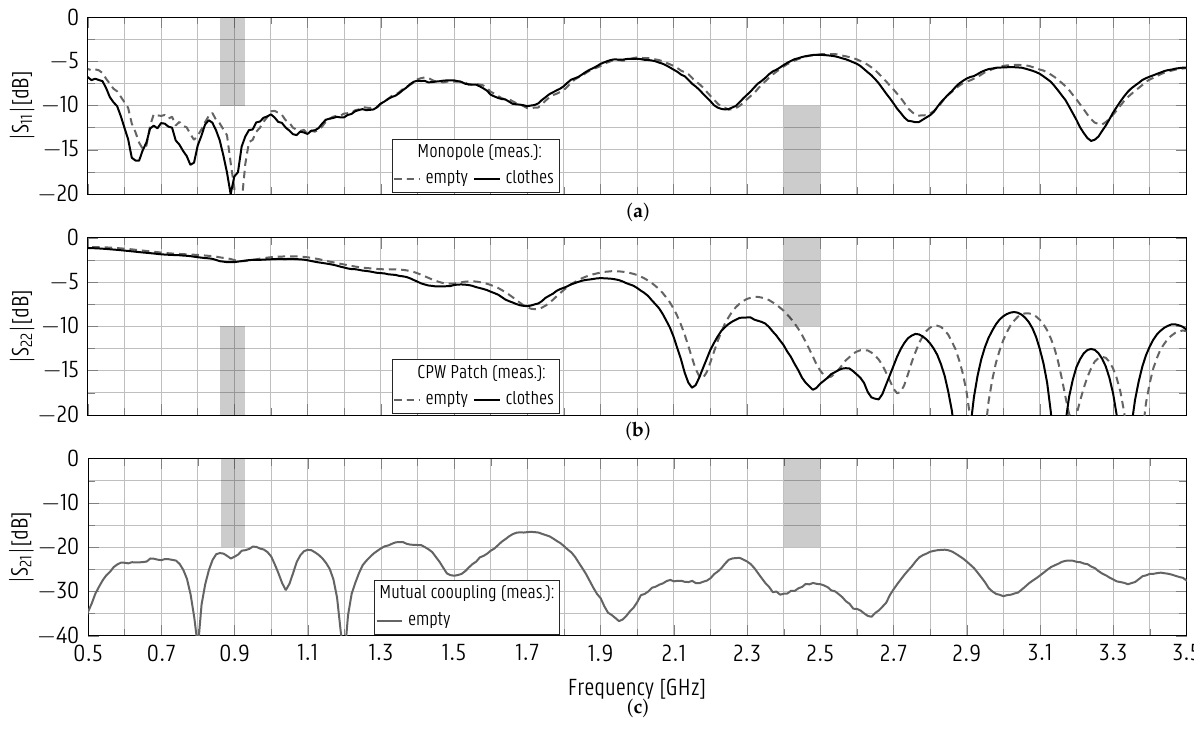
Figure 13. Measured (meas.) magnitudes of the reflection coefficient of ( a ) monopole and ( b ) redesigned CPW patch antennas as well as ( c ) their meas. mutual coupling. The antennas were overmolded in the suitcase and interconnected by the interposer PCB. The curves in ( a , b ) refer to the cases when the suitcase is empty and when it is filled with a standard set of